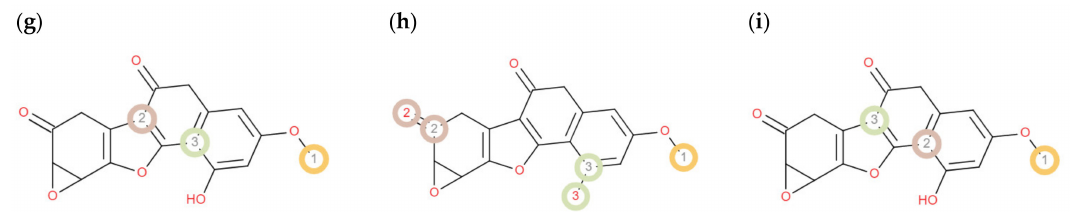
Figure 4. Prediction of DL site of metabolism by RS-Predictor at: ( a ) CYP1A2, ( b ) CYP2A6, ( c ) CYP2B6, ( d ) CYP2C8, ( e ) CYP2C9, ( f ) CYP2C19, ( g ) CYP2D6, ( h ) CYP2E1, ( i ) CYP3A4. Color code: orange: highly labile, grey: moderately labile, and light green: fairly